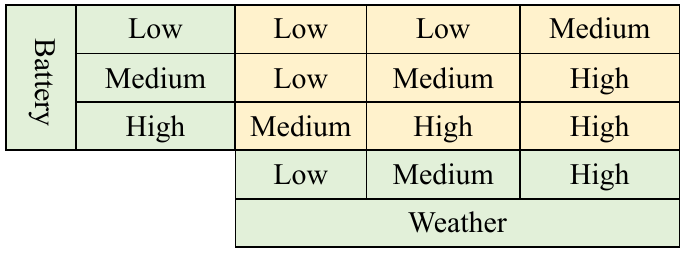
Figure 6. A representation of fuzzy rules used in the Fuzzy